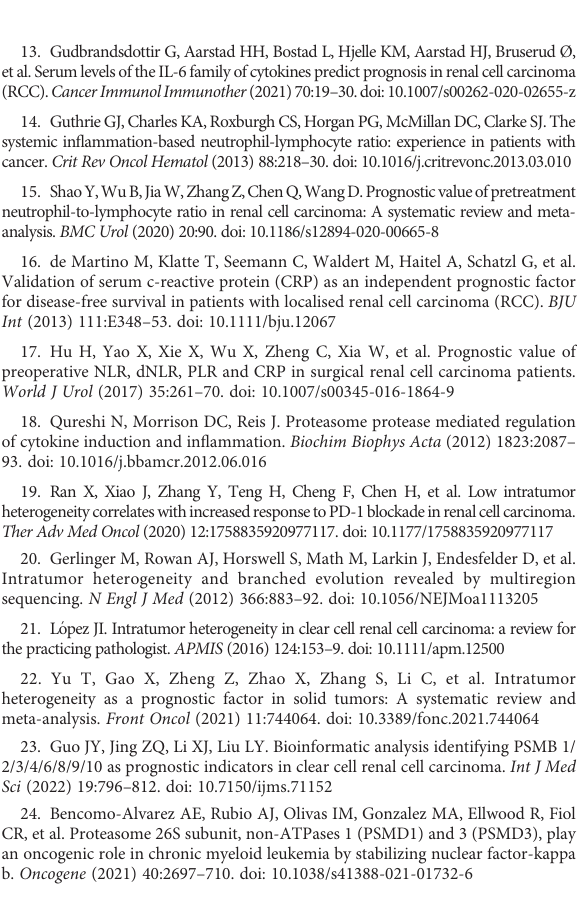
SUPPLEMENTARY FIGURE 1 Immunohistochemistry of PSMB1 and PSMB3 was performed using specimens obtained from patients with ccRCC who received radical, cytoreductive, or partial nephrectomy at our institution. (A) Typical fi ndings of negative results are shown for PSMB1 and PSMB3, with normal tubular cells stained and no cancer cells stained in the upper part of A. The magni fi ed view of the tubules are shown in the lower part of A. (B) Typical fi ndings of positive results are shown for PSMB1 and PSMB3, withnormaltubular cellsstainedandcancercellsalsostained intheupper part of B. The magni fi ed views of the tubules are shown in the lower part of B. The dotted lines show the normal tissue boundaries, including the tubules. N, normal tissue including tubules; T,